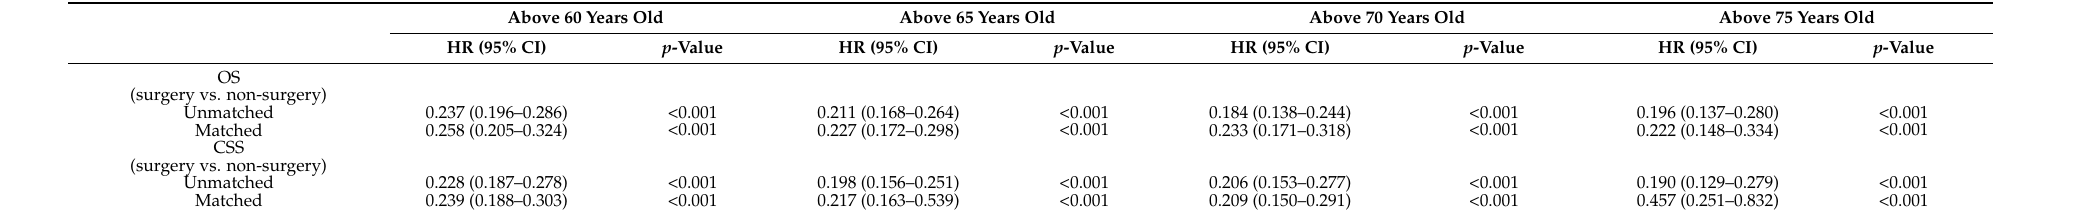
Table 2. Comparison of survival benefit on OS and CSS for ICC patients in different age stratifications before and after matched.